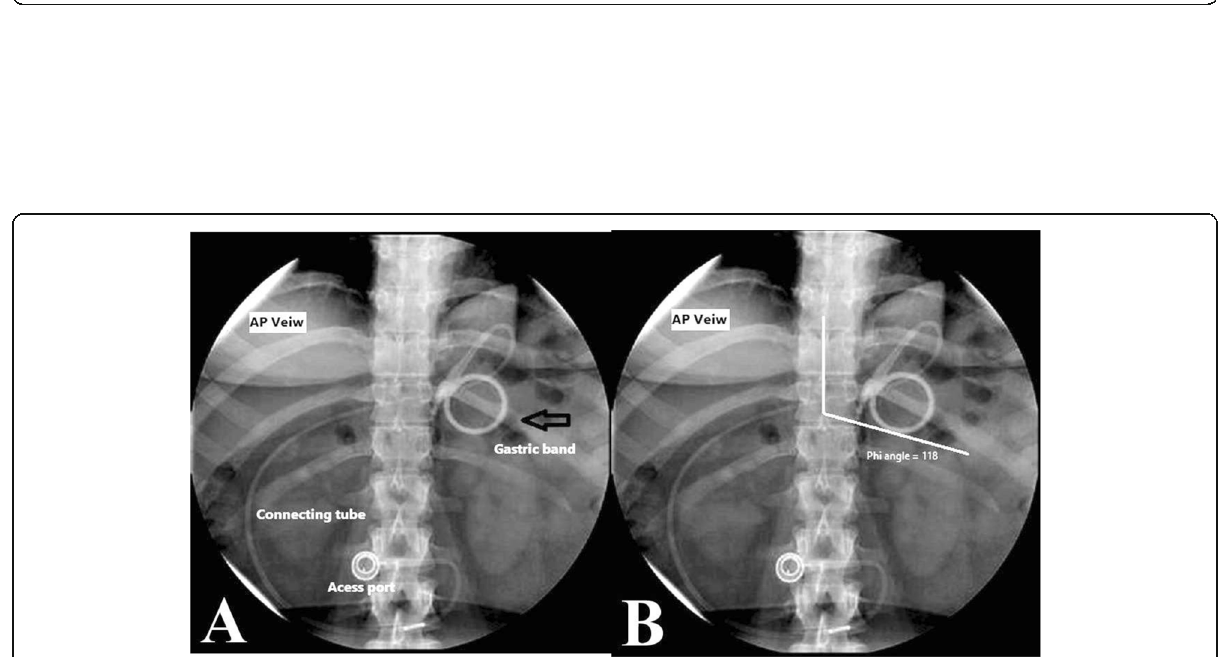
Fig. 1 A 41-years-old female patient presented with epigastric pain after the gastric band since 6 months. Plain X-ray abdomen and barium meal study: correct positioning of an adjustable gastric band at the left side of the spine and below the diaphragm with normal Phi angle = 44° (Normal 4° to 58°) and normal stoma with a diameter of 3.3 mm (normal 3 to 4 mm). Diagnosis: essentially normal